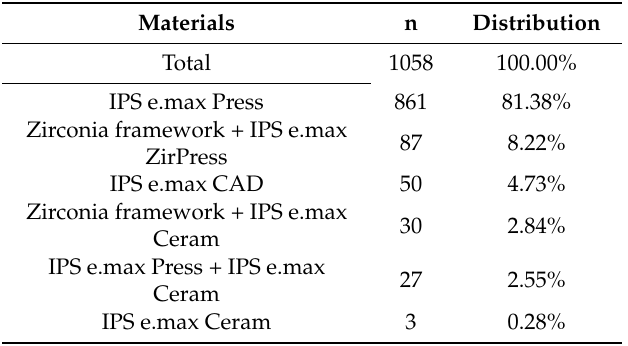
Table 1. Distribution of restorative materials across the 1058